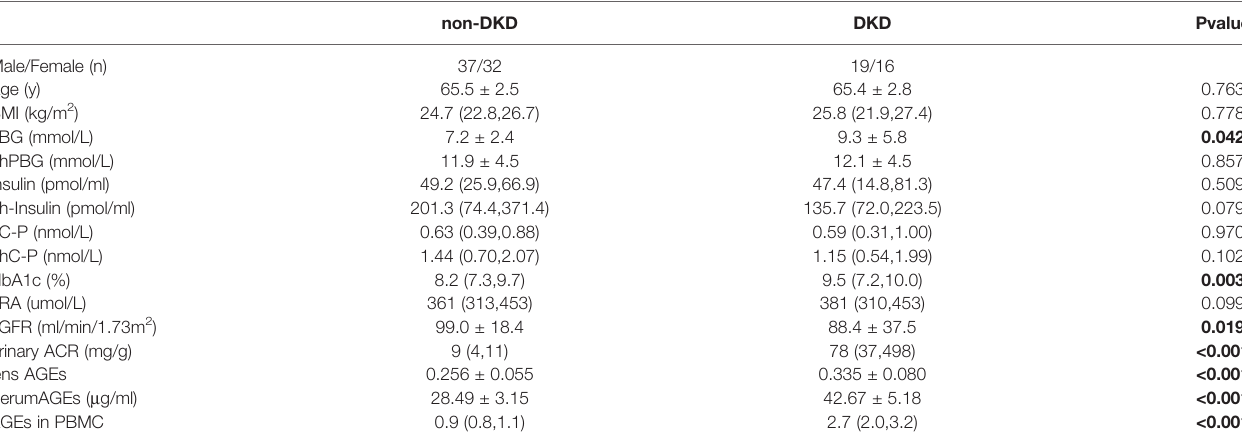
TABLE 2 | Comparison of general data and biochemical indexes of T2DM patients.